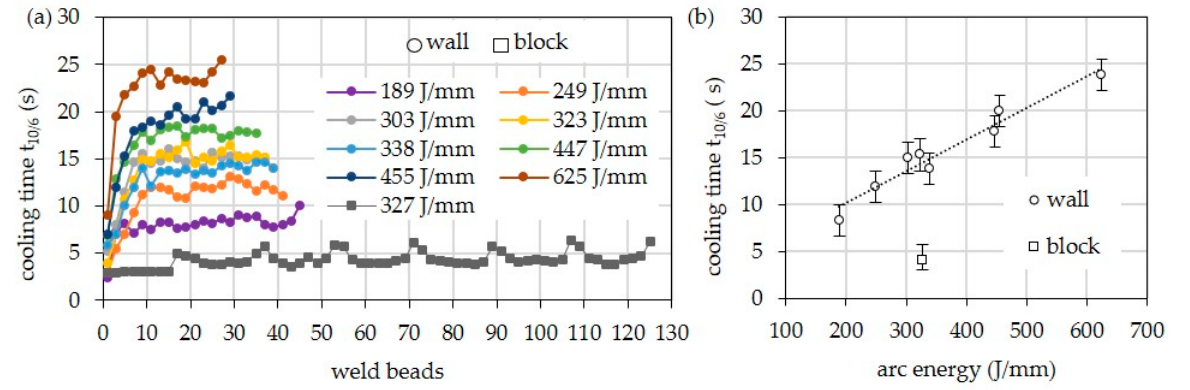
Figure 4. Cooling times of different parts (wall, block) welded with HY282 ( Φ 0.04 ″ ) and Z-ArHeHC 30/2/0.05 ( a ) depending on arc energy and weld beads and ( b ) arithmetic mean values at 11th weld bead depending on arc energy.